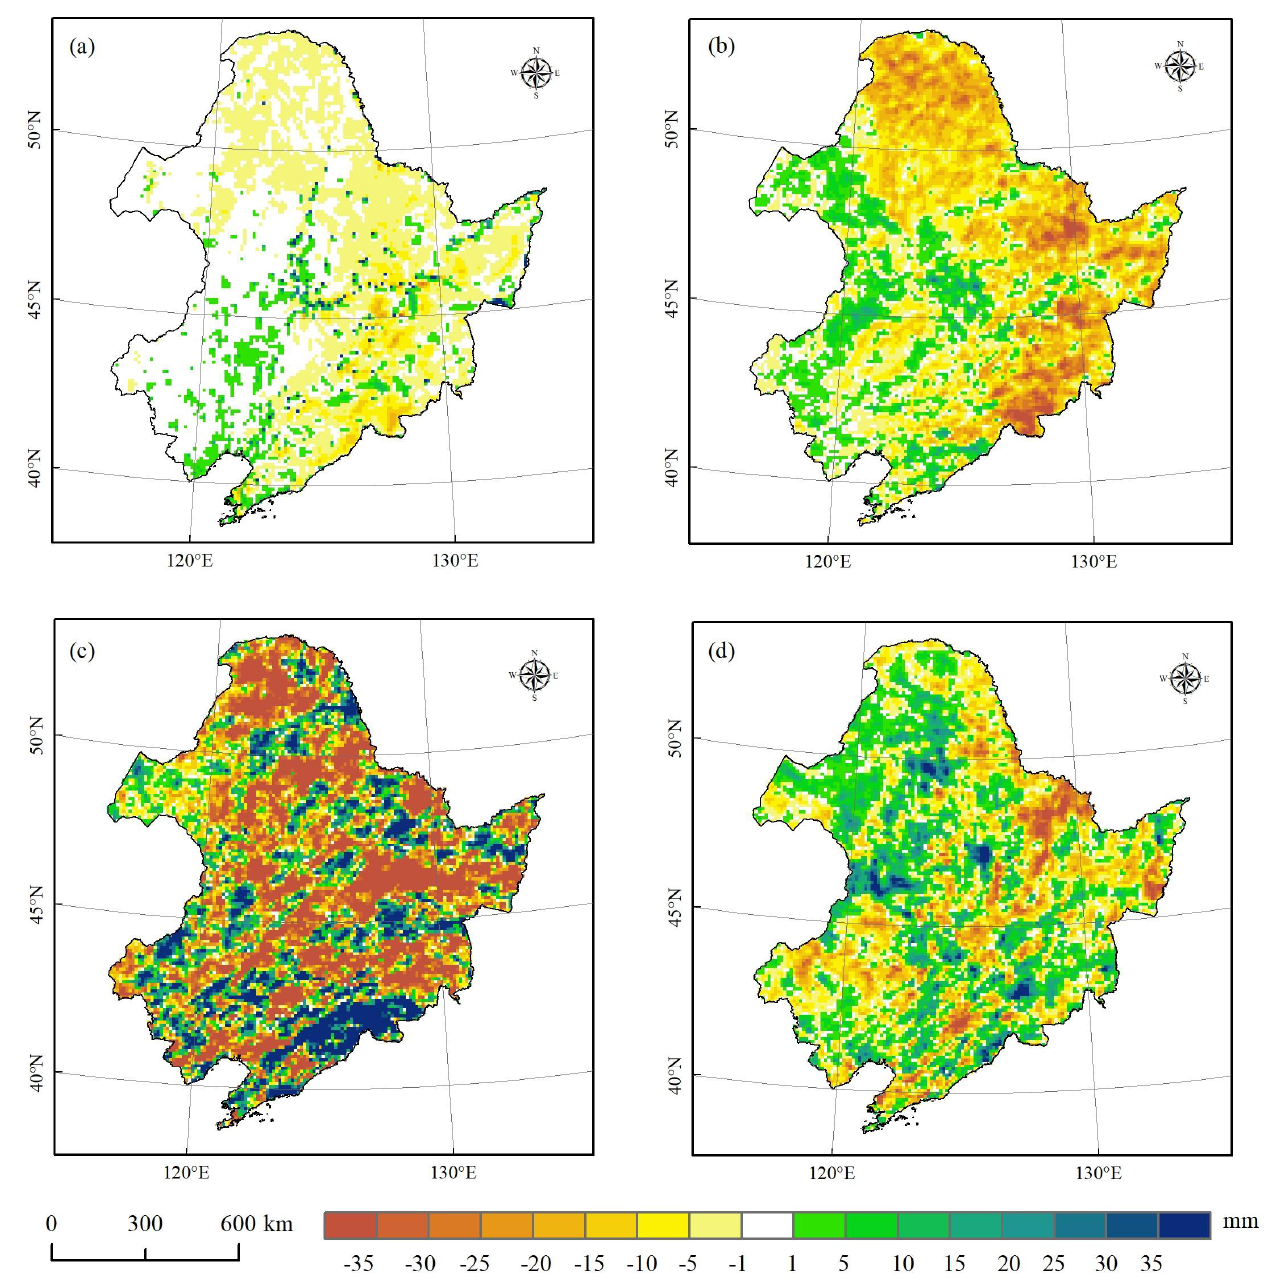
Figure 6. Differences (All-grassland scenario minus forested scenario) in precipitation (mm) in December–January– February ( a ) March–April–May ( b ) June–July–August ( c ) September–October–November ( d ) between the forested and all-grassland